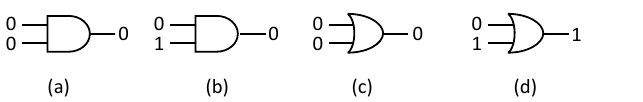
Figure 9: Four cases for GATE 0 , the top bit is l 0